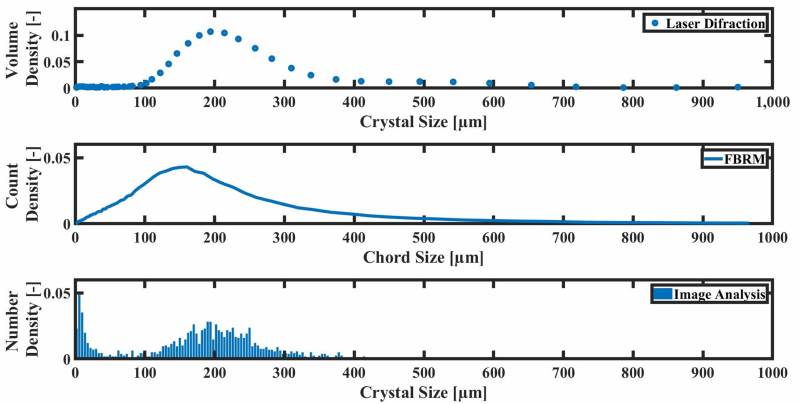
Figure 6. The comparison of crystal population distributions (fractional density distributions) of product Exp P01 measured based on laser diffraction ( top ), focused beam reflectance measurement (FBRM) ( middle ), and image analysis ( bottom )